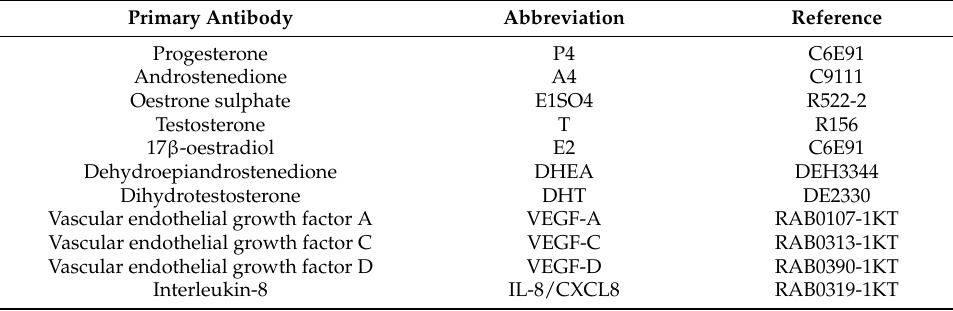
Table 1. Evaluated hormones and antibodies used for EIA determinations. Primary Antibody